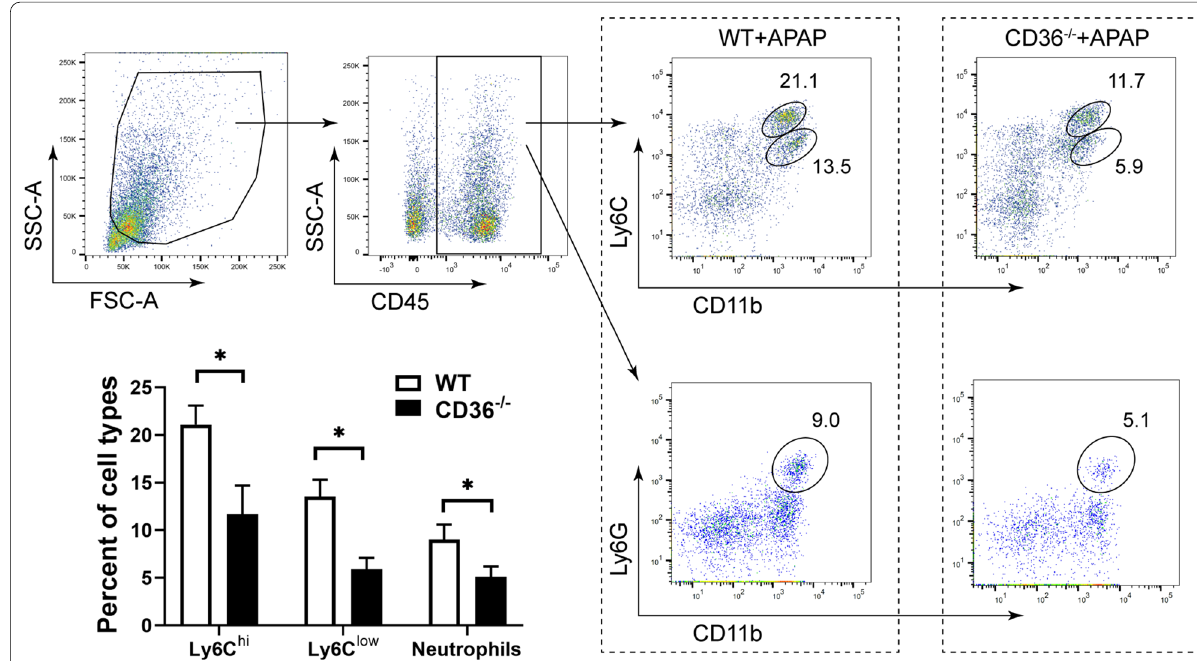
Fig.4 Infiltrating monocytes and neutrophils were deceased in CD36 − / − mice. LMNCs were purified from APAP treated mice and stained with CD11b, Ly6C and Ly6G antibodies. Infiltrating monocytes (CD11b + Ly6C + ) and neutrophils (CD11b + Ly6G + ) were analyzed by FACS. *P < 0.05. N mice per